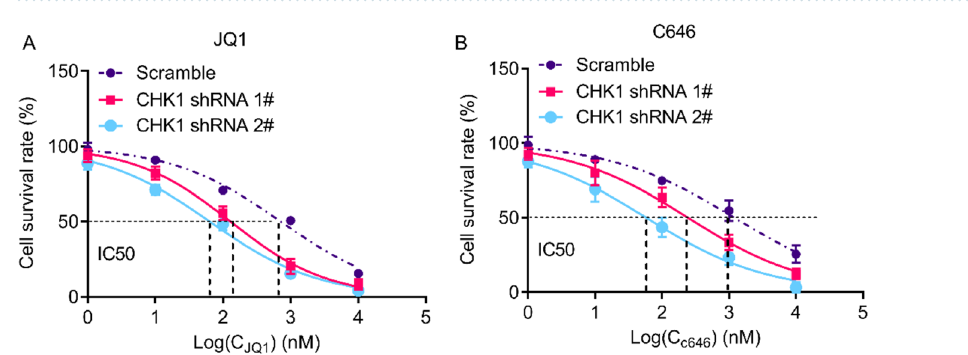
Figure 5. CHK1 knockdown increases the sensitivity of MV4-11 cells to epigenetic inhibitors. ( A ) MV4-11 cells transfected with CHK1 shRNA were treated with increasing concentrations of JQ1 for 24 h. CCK8 assay measured the cell viability. ( B ) MV4-11 cells transfected with CHK1 shRNA were treated with increasing concentrations of C646 for 24 h. CCK8 assay measured the cell